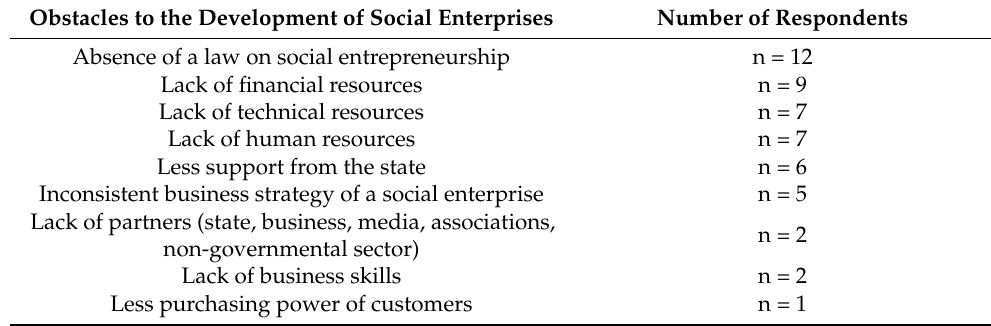
Table 5. In your opinion, what are the factors that prevent the development of your social enterprise? Obstacles to the Development of Social Enterprises Number of Respondents Absence of a law on social entrepreneurship n = 12 Lack of financial resources n = 9 Lack of technical resources n = 7 Lack of human resources n = 7 Less support from the state n = 6 Inconsistent business strategy of a social enterprise n = 5 Lack of partners (state, business, media, associations, n = 2 non-governmental sector) Lack of business skills n = 2 Less purchasing power of customers n =